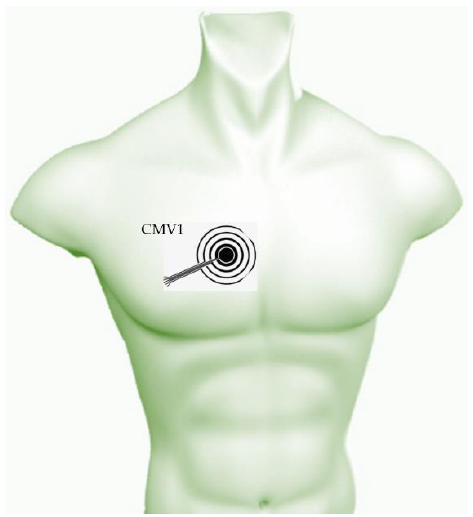
Figure 3. Schematic of the placement of the wireless sensor node at position CMV1 (comparable to V1) for electrocardiogram (ECG) recording.